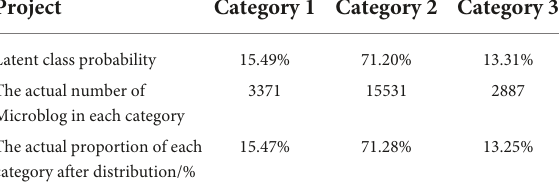
TABLE 6 The proportion of each Microblog after